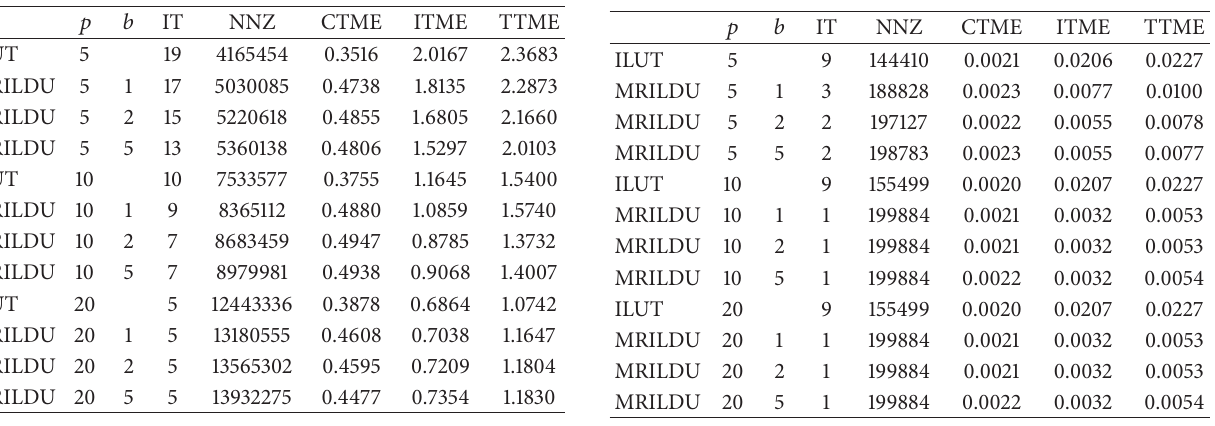
Table 7: Iteration results for matrix cvxbqp1.